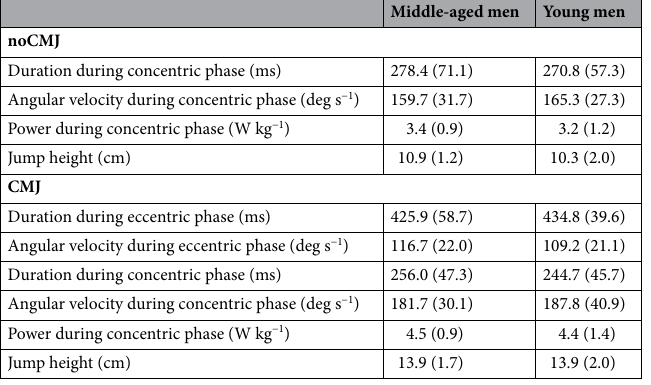
Table 3. Measured variables during the two types of jumping tests Mean (sd). noCMJ no-countermovement jump, CMJ countermovement